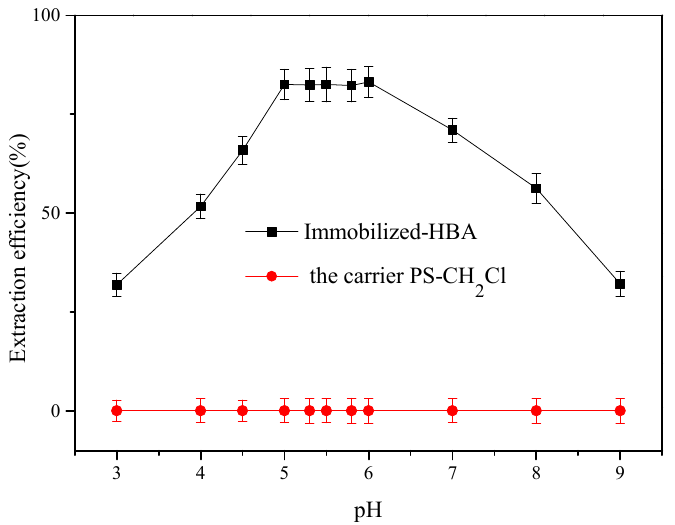
Figure 2. Influence of the pH on the extraction efficiency of arbidol. Conditions: C arbidol = 25 mg/L, t = 30 min, T = 20 °C.